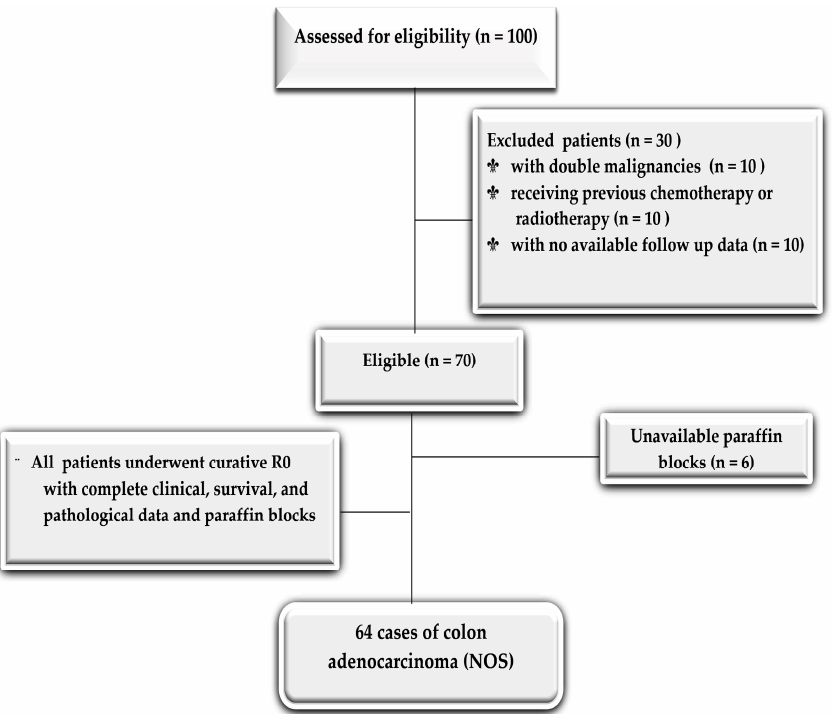
Figure 1. Consort flow diagram for the selection of the study cohort.